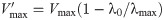
Effects of constitutive resistance genes on the shape of dose-response curves and surfaces.(A) Expression of unregulated (constitutive) gene depends on nutrient quality and degree of translation inhibition. Top: When growth is varied by nutrient quality, the expression of the gene decreases with increasing growth. The highest expression achieved in the limit of low growth rates is determined by Vmax (different shades of gray). When λ0 = λmax, expression ceases, invariantly of Vmax. Bottom: In a fixed nutrient environment (circles), expression decreases as the growth rate decreases upon translation inhibition. The expression in the absence of antibiotic is Vmax′=Vmax(1-λ0/λmax) [gray arrow; for the environment with lower λ0 (white disk)]. (B) Schematic of positive feedback loop for unregulated antibiotic resistance gene. A drug-resistance enzyme degrades the antibiotic, thus reducing growth inhibition and boosting its own expression. However, if the antibiotic concentration exceeds the capacity of removal by the enzyme, growth rate starts to drop and so does the expression of the resistance enzyme, amplifying the growth rate drop. The lightly drawn part (right) illustrates how two antibiotics can get coupled via the growth-rate dependent loop. (C) Examples of dose-response curves in the presence or in the absence of a constitutively expressed resistance gene (CERG). Black line shows dose-response curve for α = 1. When a CERG is added [Vmax′=1000
μM h−1, Krem = 0.1 μM the dose-response curve becomes steeper and exhibits an abrupt drop. Inset shows the increase in antibiotic concentration required to halve the growth rate relative to the no-CERG case as a function of Vmax′. (D) Dose-response surface for independently (top) and competitively (bottom) binding antibiotics with α = 1; resistance activity Vmax′ (assumed to be identical for both antibiotics) increases from left to right: 0, 100 and 950 μM h−1. Concentration axes were rescaled with respect to the increased IC50. Note the qualitative change in dose-response surface shape.